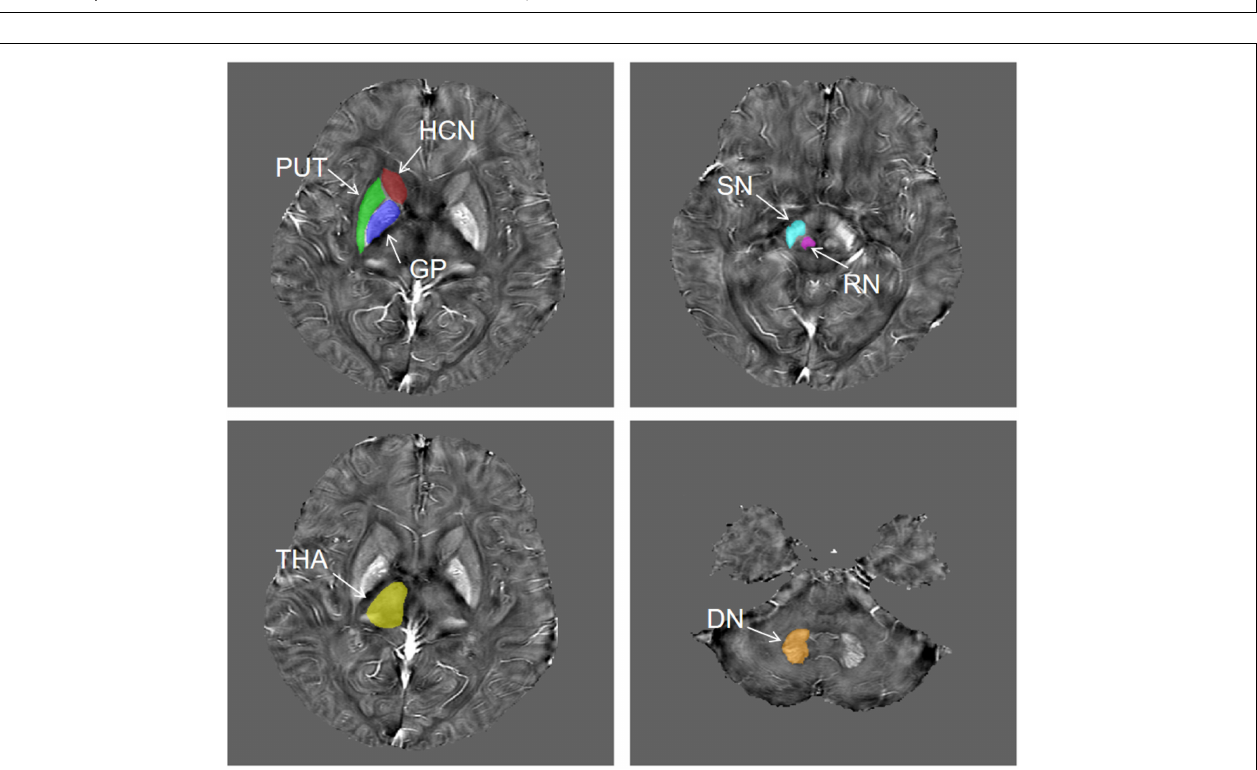
FIGURE 2 | The representative unilateral outlines of the defined ROIs. The ROIs included the putamen (PUT), globus pallidus (GP), head of the caudate nucleus (HCN), thalamus (THA), substantia nigra (SN), red nucleus (RN), and dentate nucleus (DN) bilaterally.